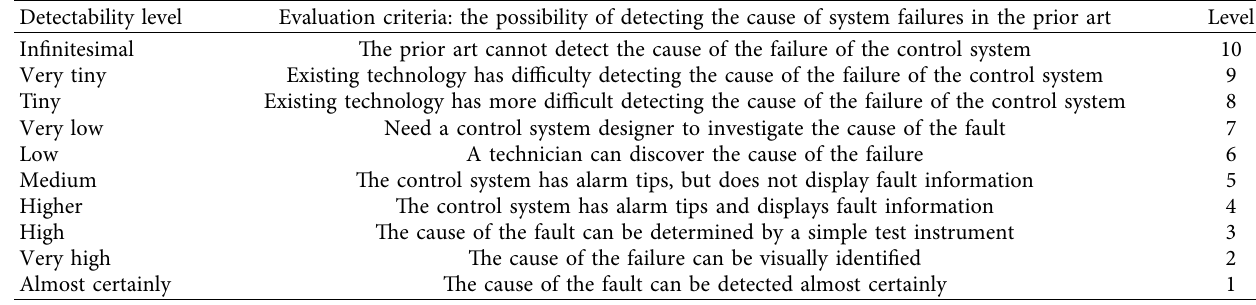
Table 13: Scoring criteria for the degree of detection D